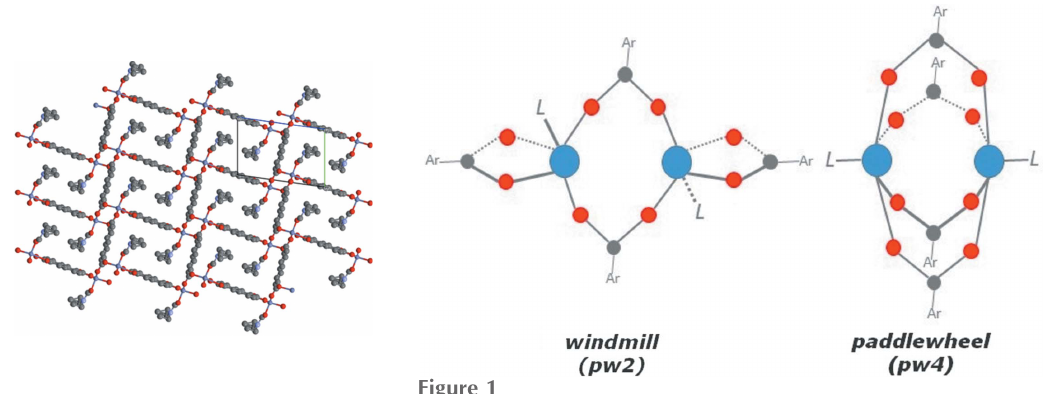
(left) and of a typical zinc four-blade paddlewheel (pw4) cluster